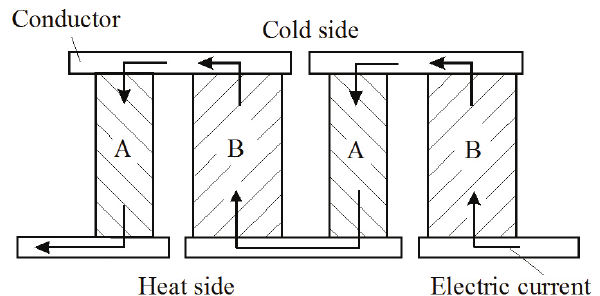
Figure 1. TEG (thermoelectric